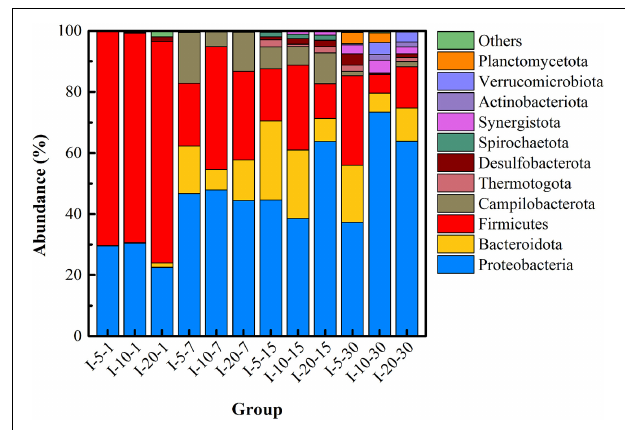
FIGURE 9 | Microbial community structure at phylum level under different inoculation